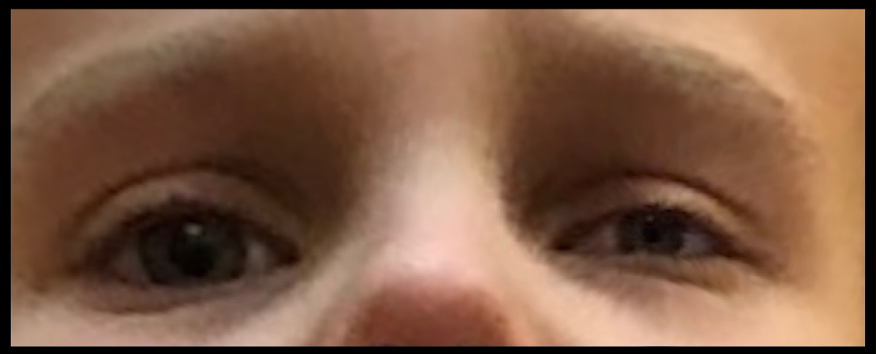
Figure 7. The child presented with worsening left-sided ptosis, miosis, and anhidrosis.